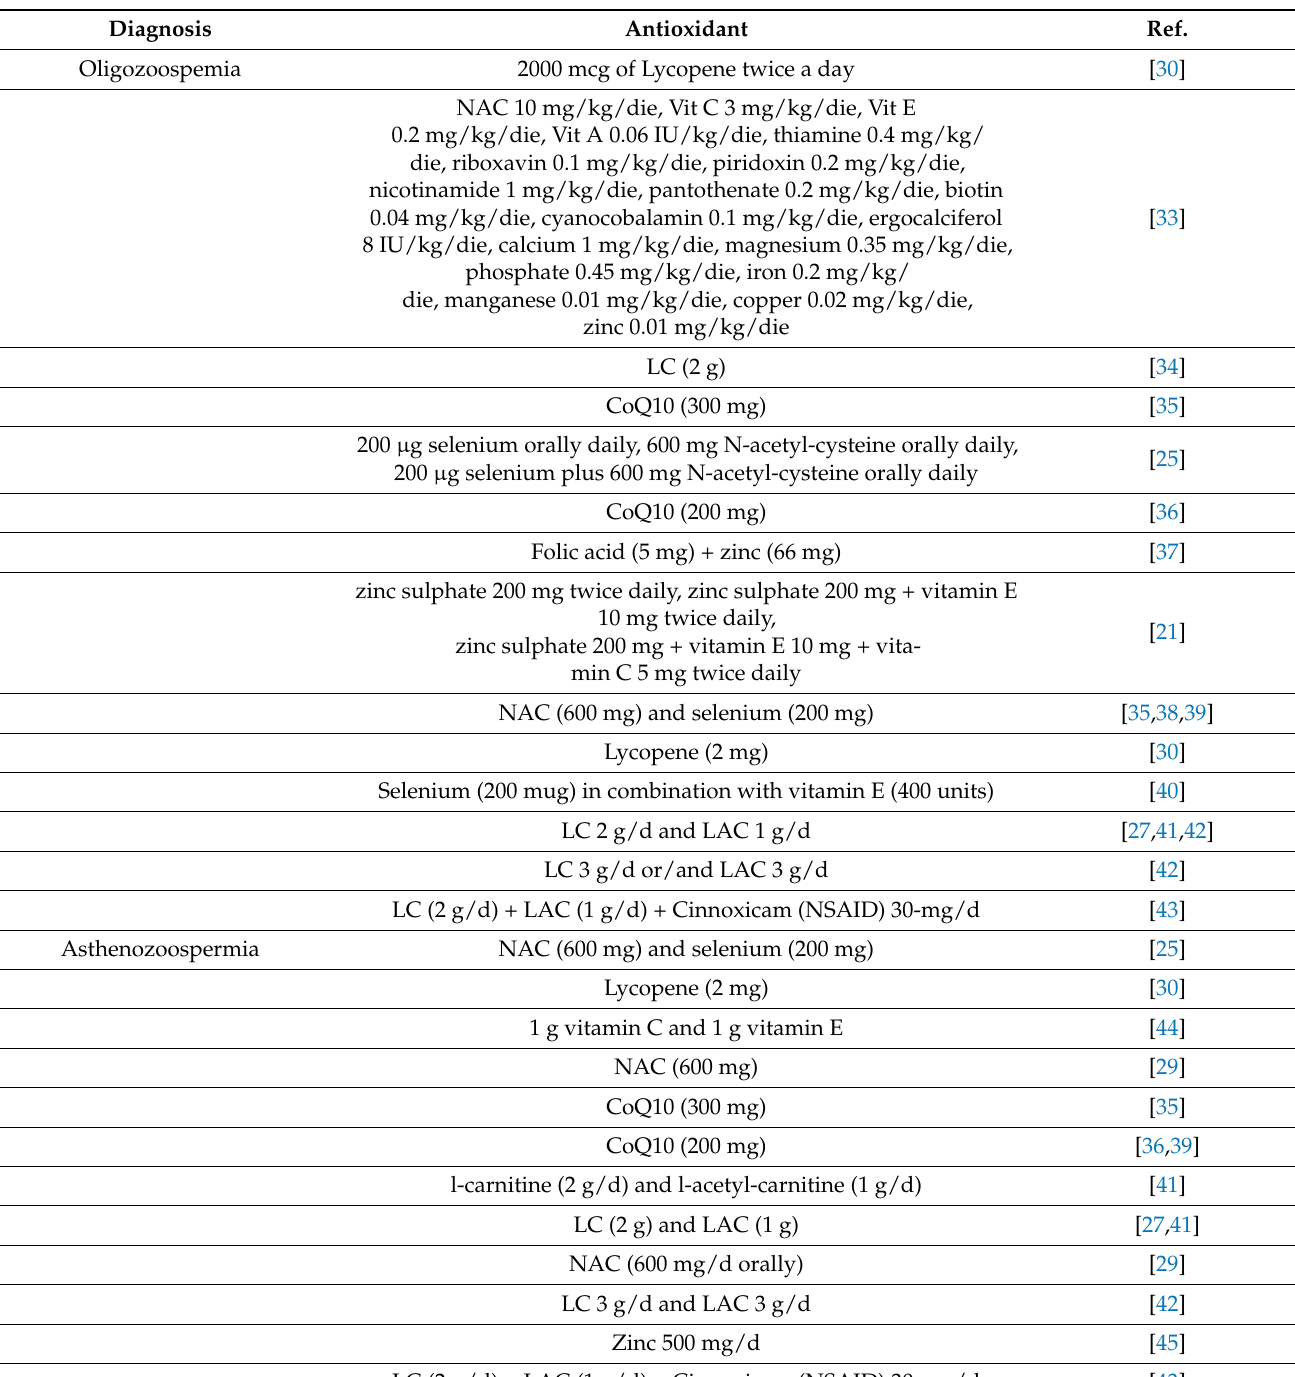
Table 2. List of antioxidants with proposed indication in reviewed evidence